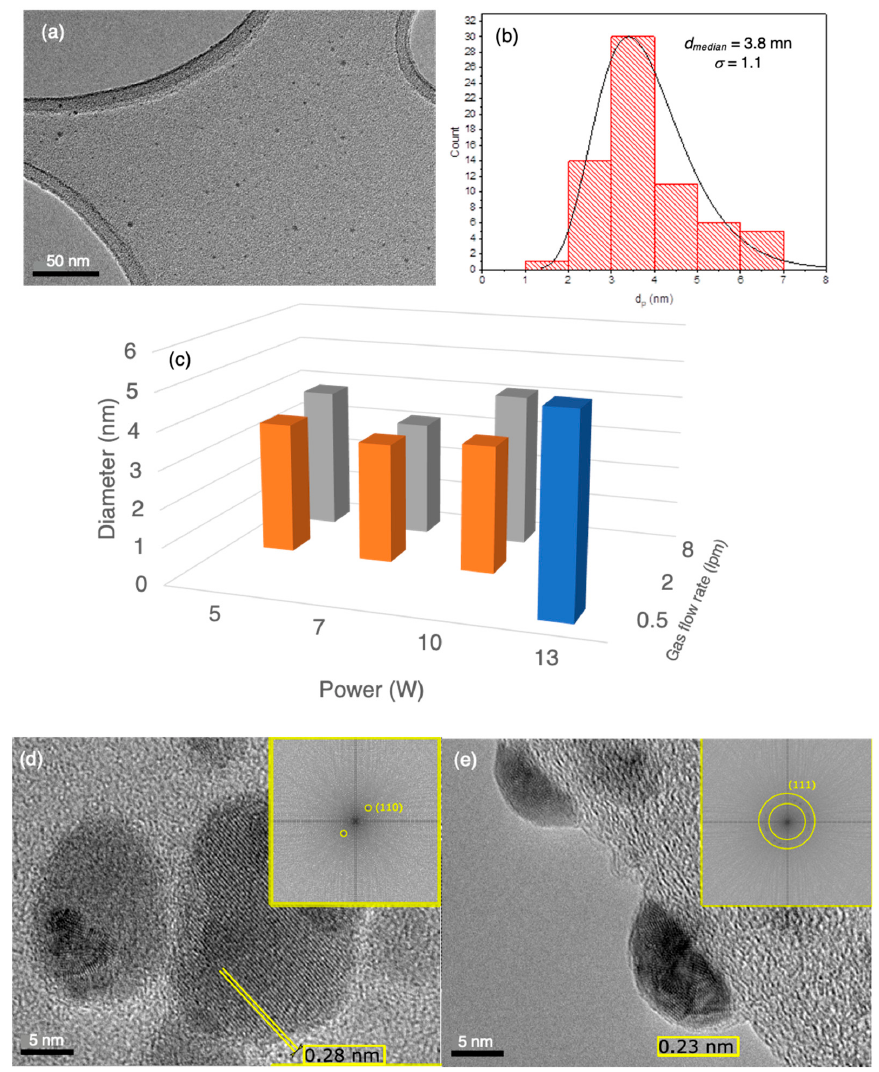
Figure 3. Characterisation of gas phase nanoparticles. ( a ) Typical field of Ag nanoparticles produced with a power setting of 5 W and a gas flow rate of 8 lpm indicating a particle diameter below 5 nm. ( b ) Size histogram for the same source conditions fitted to a log-normal distribution, with the median diameter and standard deviation indicated. ( c ) Variation of the median diameter with the power and gas flow rate in the source. ( d ) TEM image of an individual nanoparticle at a lacy carbon edge with a monocrystalline structure as indicated by single pair of spots corresponding to the Ag (110) planes in the FFT shown in the inset. ( e ) TEM image of an individual nanoparticle at a lacy carbon edge showing a polycrystalline structure as indicated by a ring of spots within the yellow circles corresponding to the Ag (111) planes in the FFT shown in the inset.